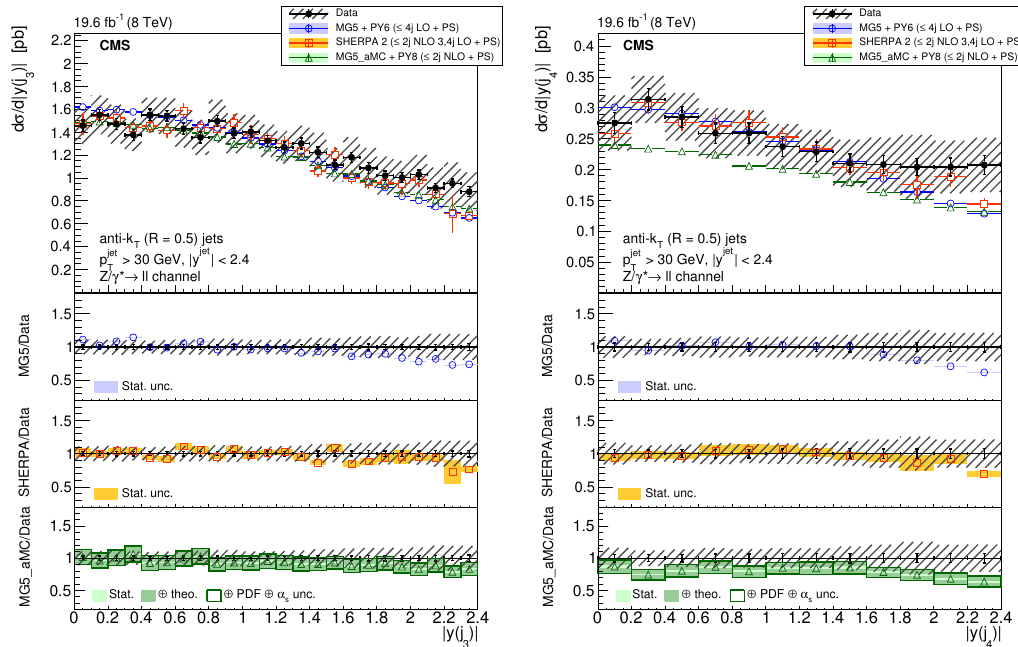
Figure 7 . The di(cid:11)erential cross section for Z ( ! ‘‘ ) + jets production measured as a function of the (left) 3 rd and (right) 4 th jet j y j compared to the predictions calculated with MadGraph 5 + pythia 6, sherpa 2, and mg5 a mc + pythia 8. The lower panels show the ratios of the theoretical predictions to the measurements. Error bars around the experimental points show the statistical uncertainty, while the cross-hatched bands indicate the statistical and systematic uncertainties added in quadrature. The boxes around the mg5 a mc + pythia 8 to measurement ratio represent the uncertainty on the prediction, including statistical, theoretical (from scale variations), and PDF uncertainties. The dark green area represents the statistical and theoretical uncertainties only, while the light green area represents the statistical uncertainty